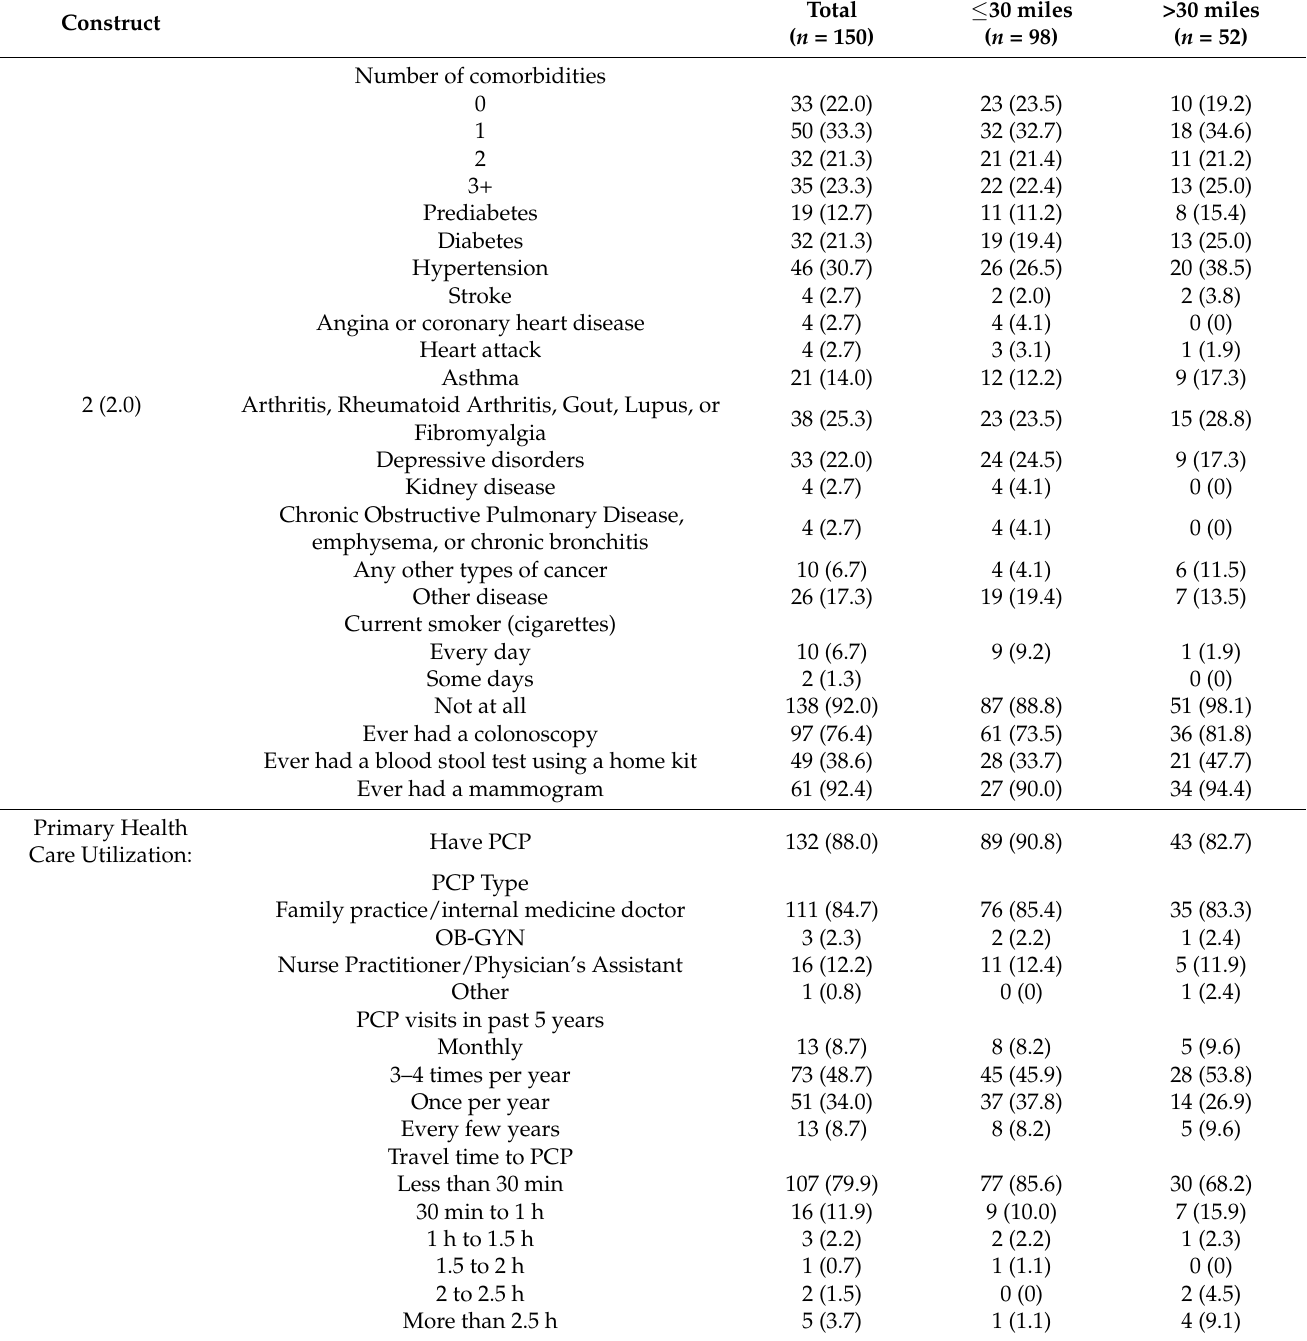
Table 2. Healthcare Access and Utilization by Place of Residence and Travel Distance to Cancer Center, n (%).